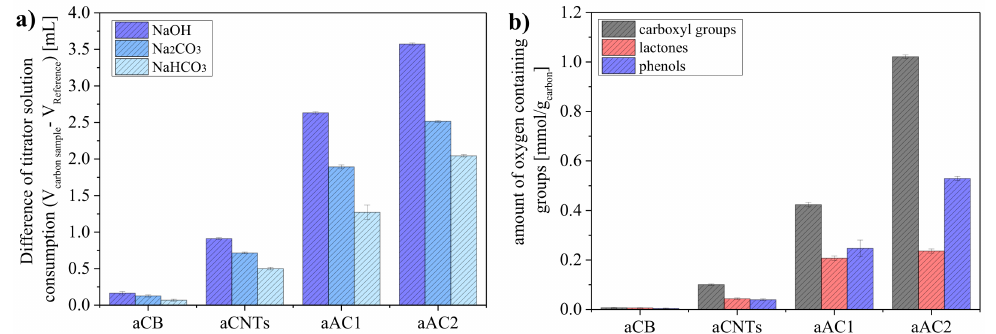
Figure 5. Boehm Titration (BT) results: ( a ) Differences of titration results between the reference base solution and carbon-treated base and ( b ) amounts of oxygen surface groups determined by using different